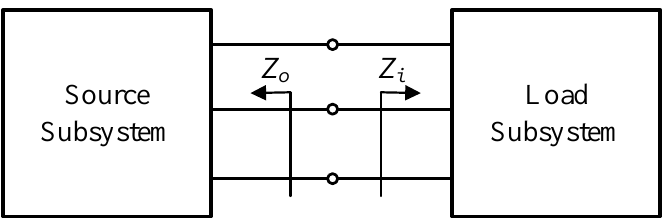
Figure 1. Interaction between source and load subsystems.